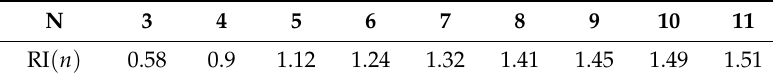
Table 4. Random index values